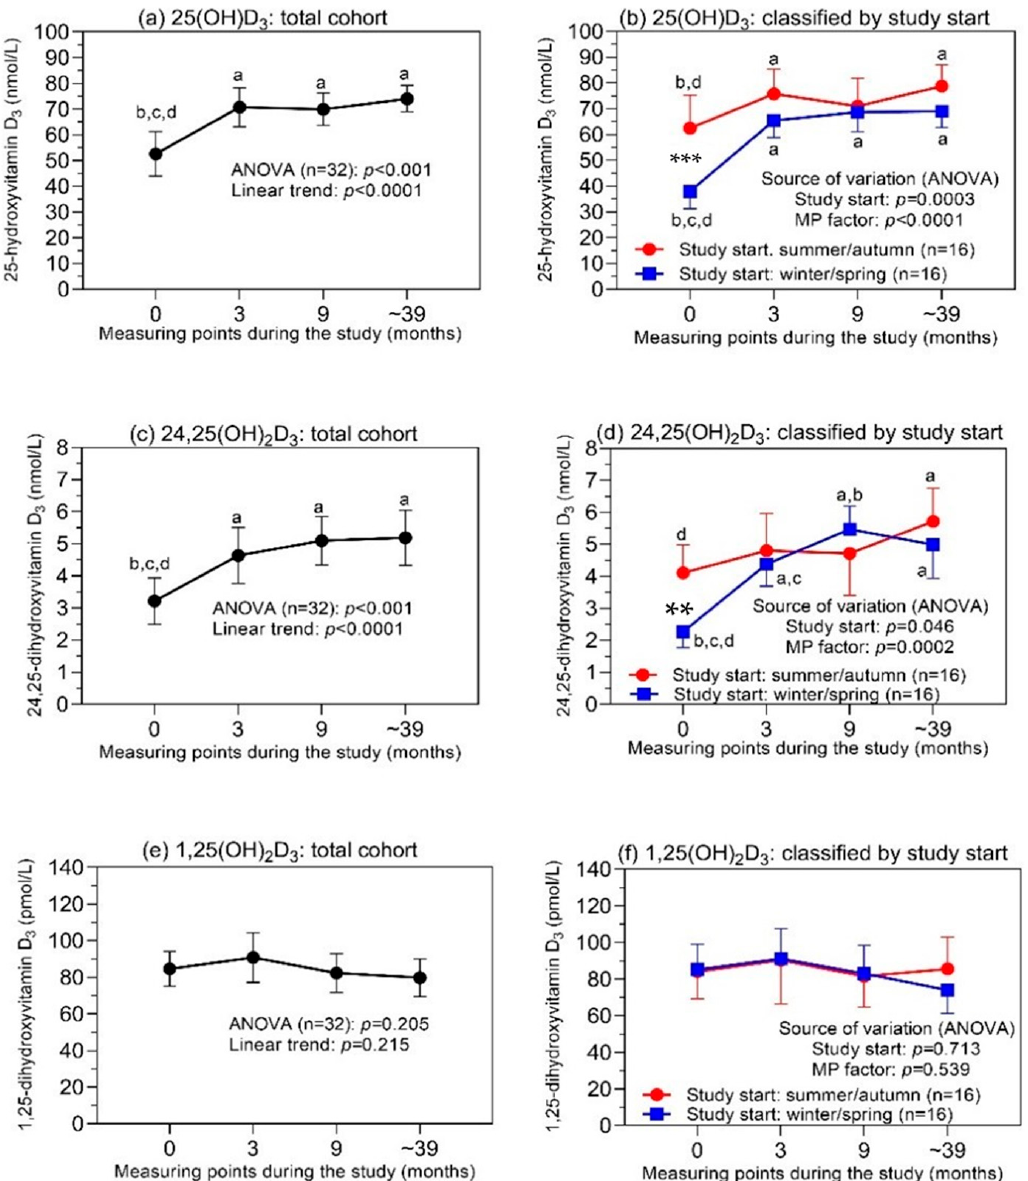
Figure 2. Levels of ( a , b ) 25(OH)D 3 , ( c , d ) 24,25(OH) 2 D 3 , and ( e , f ) 1,25(OH) 2 D 3 at different time intervals of the study in the total cohort, and dependence on the season of the start of the study. Subfigures ( a , c , e ) present the results of the repeated-measures ANOVA for a single-factor study after treatment in the total cohort ( n = 32). The corresponding subfigures ( b , d , f ) show the results of the two-factor study with repeated-measures ANOVA on the factor “study start” (winter/spring, n = 16, and summer/autumn, n = 16). Repeated measures were performed before the treatment (time point = 0) and 3 and 9 months after the treatment start. The last time point was 39 months (mean value) after the treatment start. Data at the time points are mean values with their 95% confidence intervals. At the error bars, the letters a, b, c, and d indicate statistically significant differences in the vitamin D 3 levels between the different measuring points (at least p < 0.05; corrected values according to Holm–Sidak test): a, compared to “before study”; b, compared to 3 months; c, compared to 9 months; d, compared to ~39 months. Statistically significant differences between the metabolite levels of the two study subgroups at the respective time points are characterized by asterisks: **, p < 0.01; ***, p < 0.001. Abbreviations: ANOVA = analysis of variance; MP factor = related to the time intervals of the measuring